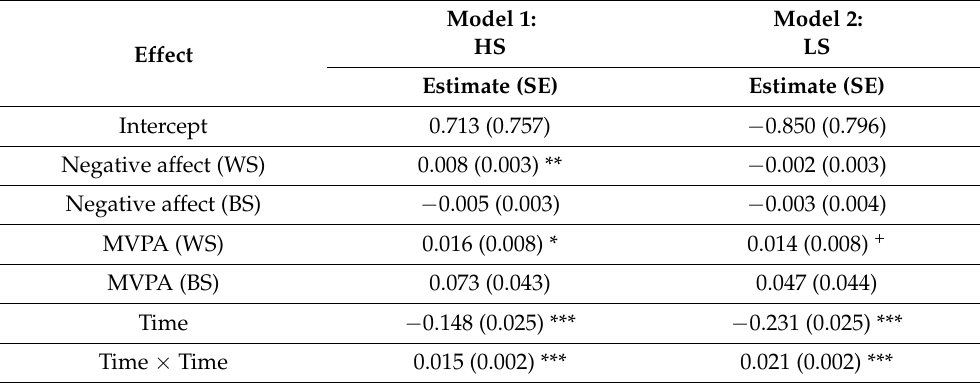
Table 2. Negative affect, time spent in MVPA, and cortisol levels by meal type.